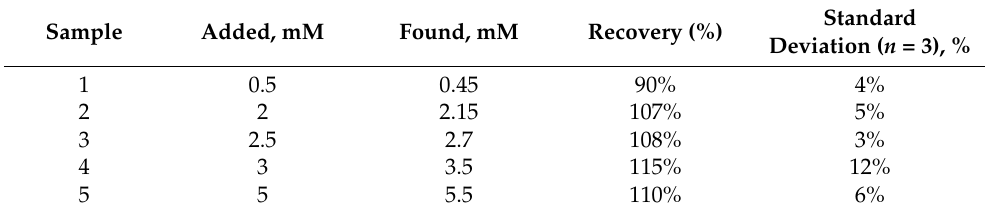
Table 1. H 2 O 2 recovery tested by using the SERS